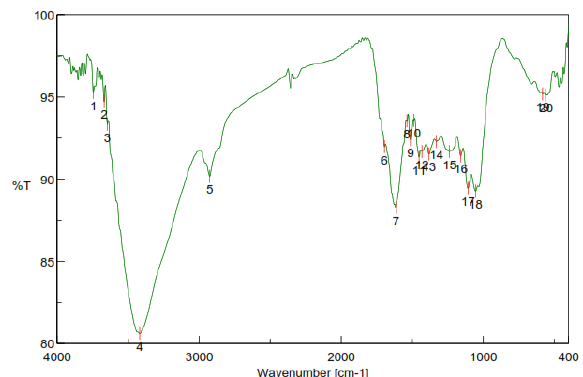
Fig. 1: FTIR spectrum of bamboo activated carbon before adsorption